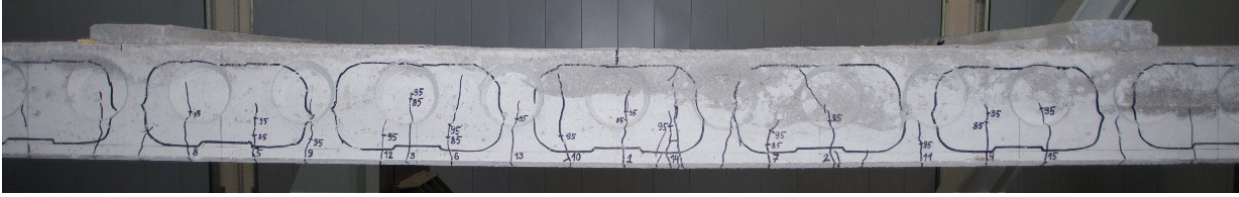
Figure 13. Distribution of cracks at voids and webs.